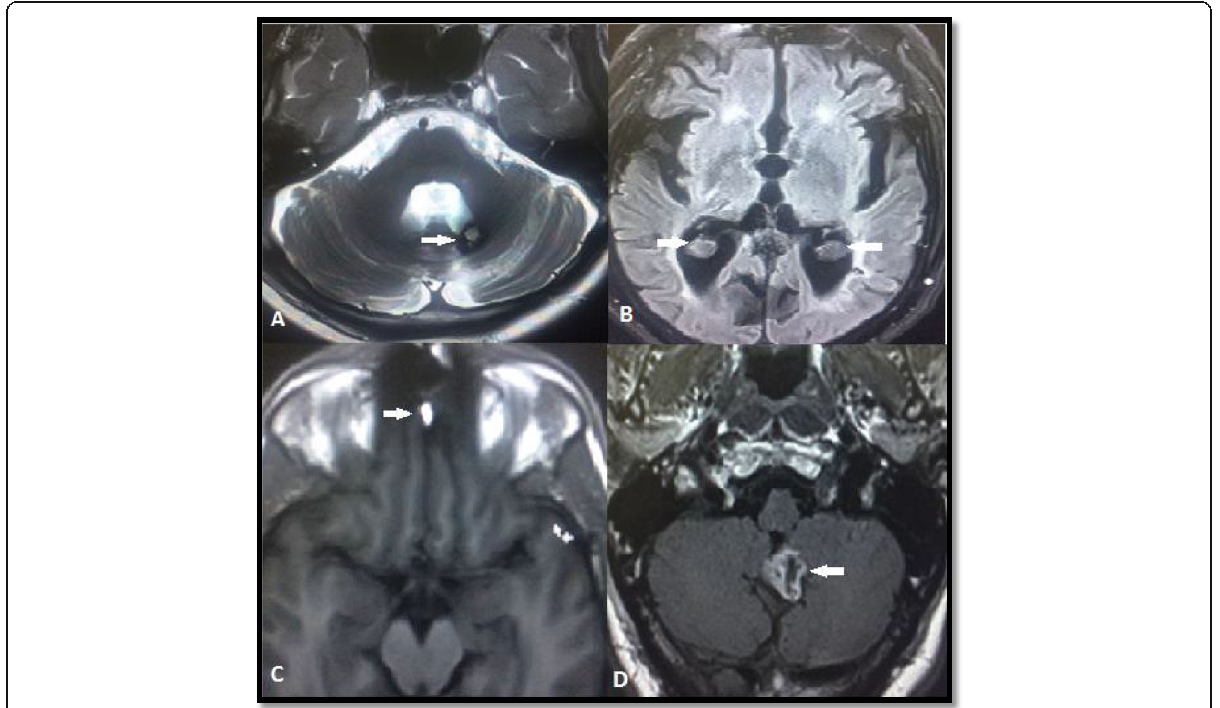
Fig.1 A selection of the incidental findings detected in our study. a Axial T2WI of the posterior fossa showing a left cerebellar hemisphere cavernoma (arrow). b Axial FLAIR image showing bilateral choroid plexus cysts (arrows). c Axial T1WI showing small inter-hemispheric lipoma (arrow). d Post contrast axial T1WI of the posterior fossa showing a heterogeneously enhancing mass in the 4th ventricle (metastasis)